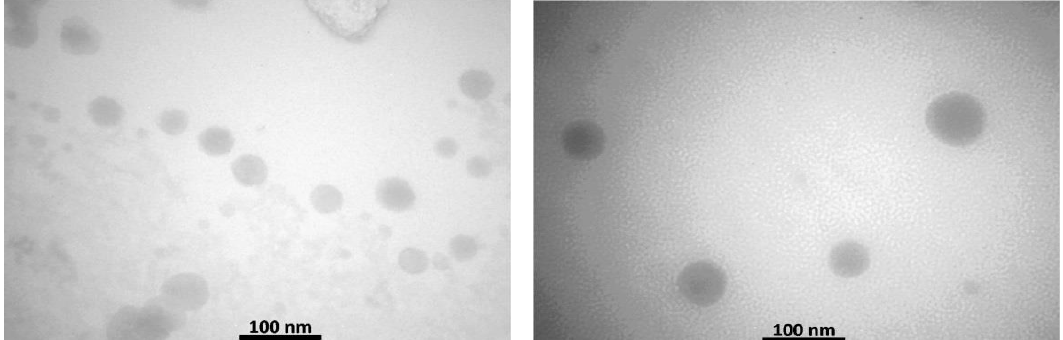
Figure 2. Transmission electron micrographs of conventional SNE (formula A; left side) and supersaturable-SNE containing soluplus (formula SAS; right